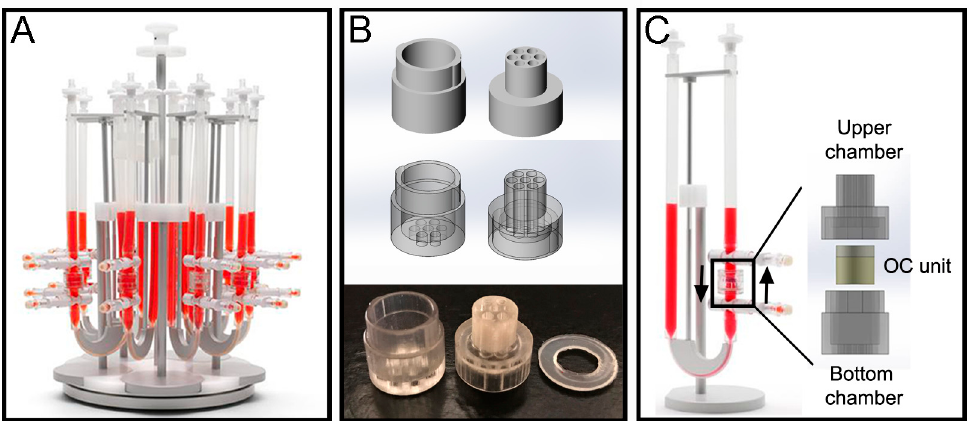
Figure 2. Culture of OC plugs in perfusion culture platform and custom made fluidic chamber. ( A ) Picture of the U-CUP based CellecBiotek ® perfusion bioreactor (Basel, Switzerland). ( B ) SolidWorks ® sketches and picture of the chamber fabricated via laser 3D printing, which is divided into 2 compartments: the bottom chamber includes 7 inlet channels, and the upper chamber other 7 outlet channels that go into a prolonged cylinder that can fit inside the U-CUP inner chamber without compromising the closure of the chamber. A ring of poly-dimethylsiloxane (PDMS) was clamped around the outer periphery to prevent culture media leakage during the perfusion. ( C ) The OC plugs were inserted in the fluidic chamber and then loaded into the U-CUP reservoir (black square) and the fluid allowed to perfuse bidirectionally (black arrows).